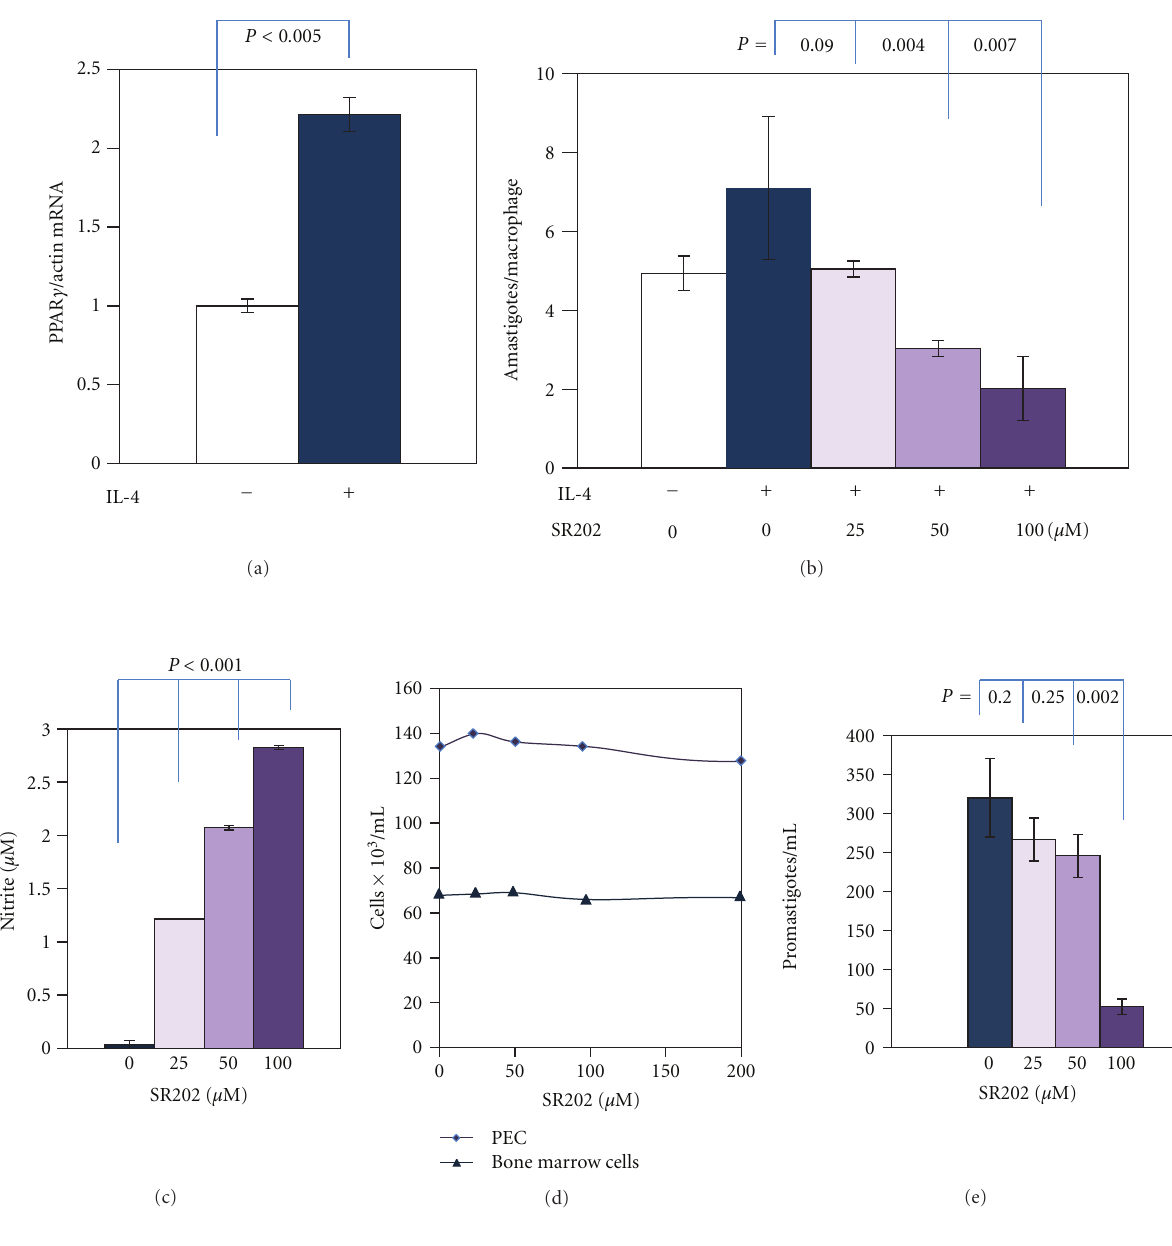
Figure 3: Blocking PPAR γ activation with an antagonist reduces L. donovani infectivity. In (a), peritoneal exudate cells were infected by L. donovani using a 1 to 10 : PEC to promastigote ratio. The cultures were incubated with 4ng/mL of IL-4 for 24 hours, then total RNA was harvested, and RT-PCRs were performed to quantify the copies of PPAR γ and β -actin mRNA as described in Adapala and Chan [16]. In (b), PECs from C57/BL6 mice were attached to cover slips and infected with L. donovani promastigotes at 1 :5 ratio. After 20 to 24 hours, 5 ng/mL of IL-4 and various concentration of SR202 were added. The infection was allowed to develop at 37 ◦ C in a 5% CO 2 incubator for another 3 days. Then, the cover slips were fixed in methanol and stained with Di ff -Quik. The degree of parasite burden was determined by enumeration under a microscope in a double-blind manner by at least two individuals. Uninfected macrophages, infected macrophages, and the number of amastigotes in these macrophages were counted. The result is reported as amastigotes/macrophage, and each data point was derived from counting at least about one hundred macrophages or one hundred infected macrophages, as appropriate. (c) shows the levels of nitric oxide in PECs that were similarly infected with L. donovani promastigotes, except that IFN γ was added instead of IL-4 to stimulated inducible nitric oxide synthase expression. On day 5, the amount of nitric oxide was determined with Griess reagent. Shown are the relative levels of nitrite, oxidized form of nitric oxide, in the culture supernatants. In (d), SR202 was added to freshly harvested, uninfected PECs and bone marrow cells at various concentrations. After 3 days, the number of live cells was determined by counting with trypan blue. In (e), SR202 was added to promastigotes, and after 5 days of proliferation, the number of parasites was determined by counting under a microscope. The results shown are representative of three independent